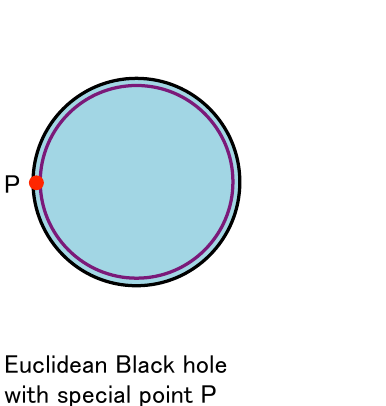
Figure 2 . The gravity interpretation of the SYK pure states. The left picture describes the gravity interpretation of pure states in Euclidean signature. The right picture describes the gravity interpretation in Lorentzian signature. The purple line is the UV cuto(cid:11) surface in Nearly AdS 2 gravity [10].